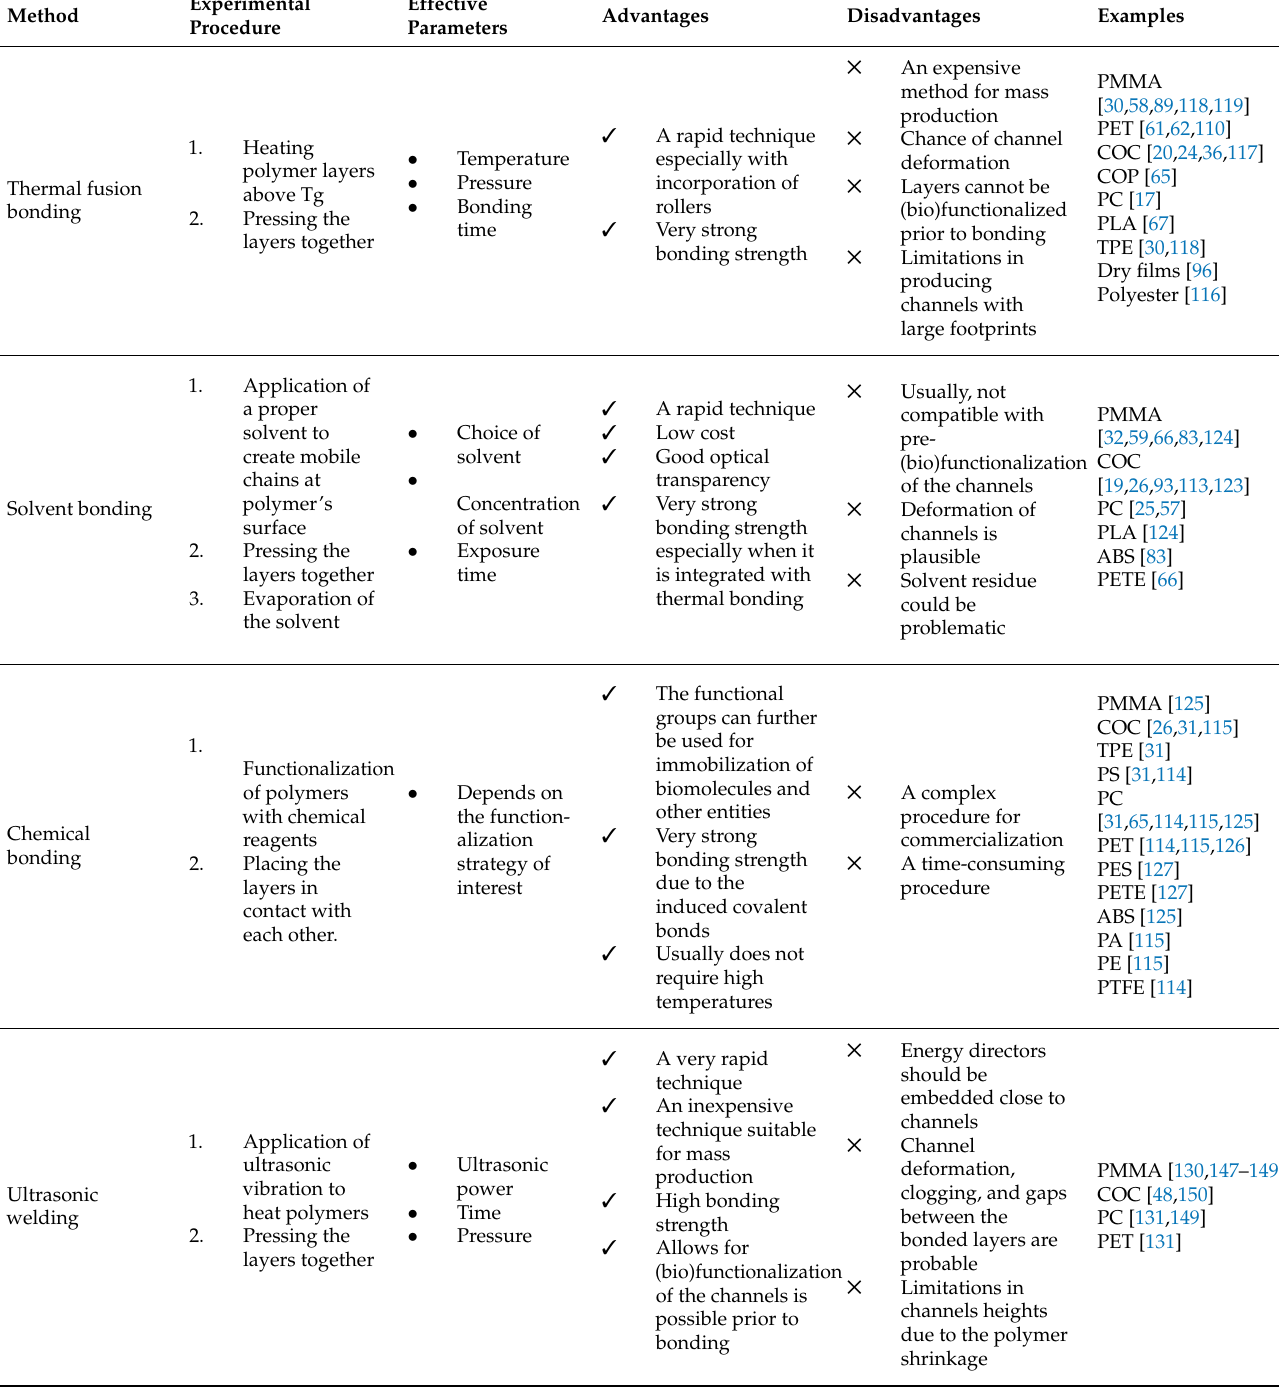
Table 2. Common strategies for bonding microfluidic